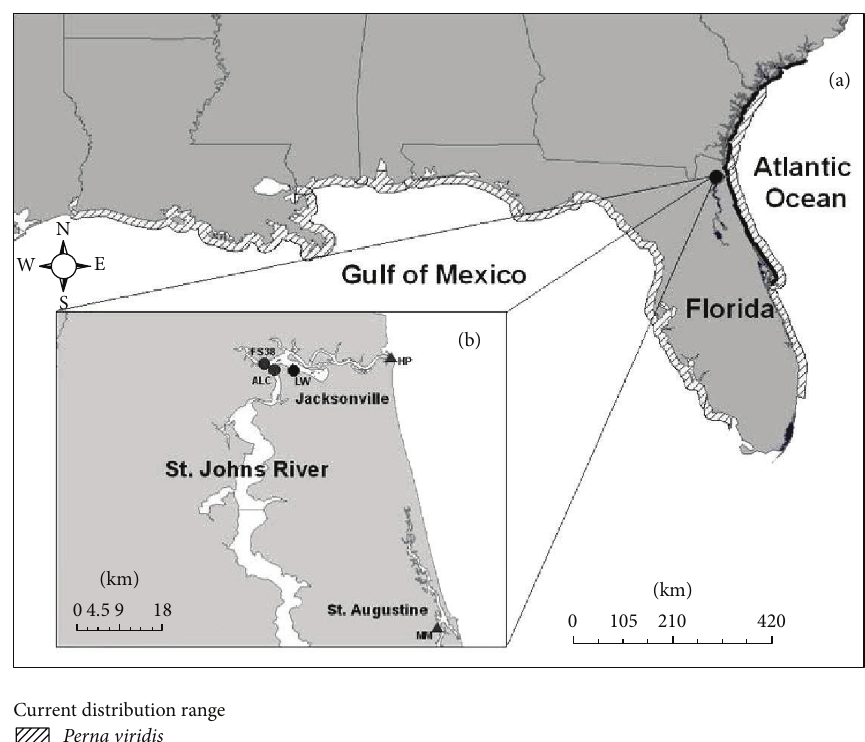
Figure 1: (a) Map of current distribution of Perna viridis and Mytella charruana and (b) collection sites for both species along Atlantic coast of Florida. 󳵳 indicates collection sites for P. viridis at Huguenot Park (HP) and Municipal Marina (MM). e indicates collection sites for M. charruana at Fire Station 38 (FS38), Arlington Lions Club (ALC), and Lonnie Wurn